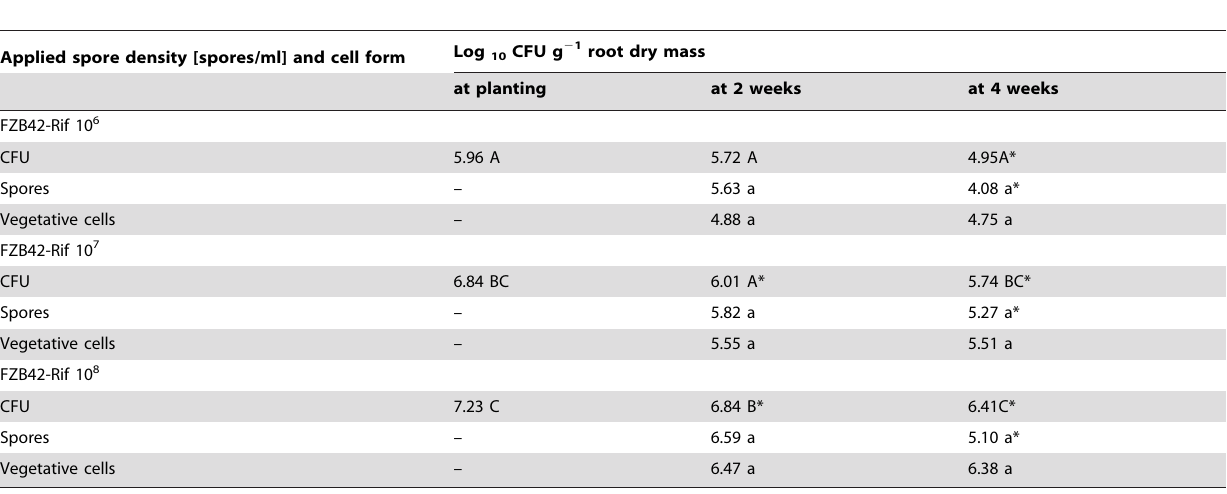
Table 1. Colonization densities of Bacillus amyloliquefaciens FZB42-Rif on lettuce root in pot experiments in respect to applied spore numbers.